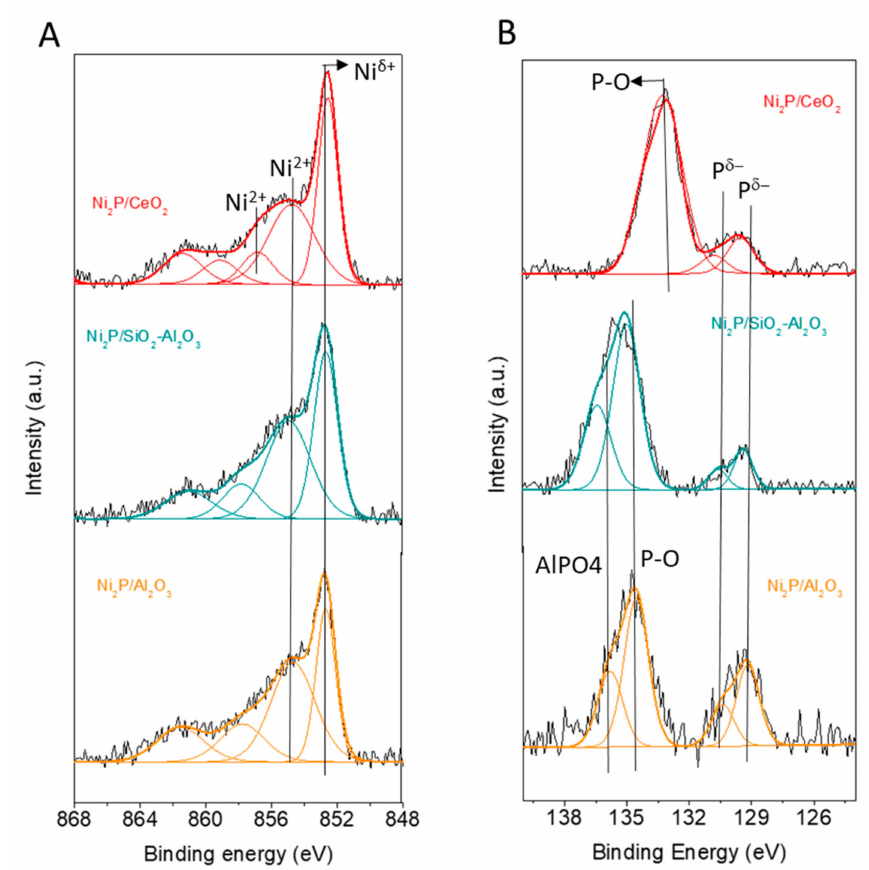
Figure 3. XPS spectra obtained for reduced samples: ( A ) Ni 2p 3/2 ; ( B ) P